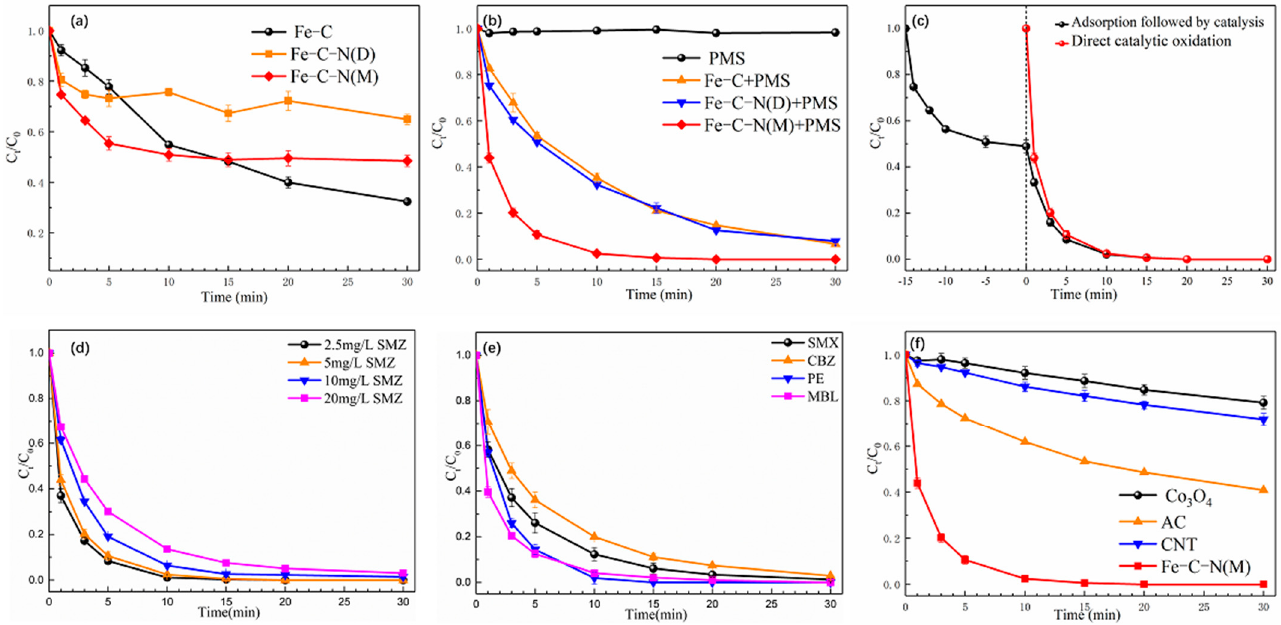
Figure 6. Adsorption ( a ) and degradation ( b ) removal efficiencies of SMZ by Fe-C-N(M); ( c ) Influ- ence image of adsorption equilibrium; ( d ) Effect of SMZ concentration ( e ) Degradation effects of Fe- C-N(M) on different pollutants; ( f ) Comparison diagram of degradation of SMZ by activation of PMS with Co 3 O 4 , AC, CNT and Fe-C-N(M); pollutant = 5 mg/L; catalyst = 50 mg/L; PMS = 0.50 mM.